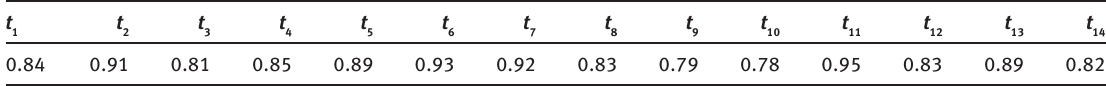
Table 2: The Executable Degree of 14